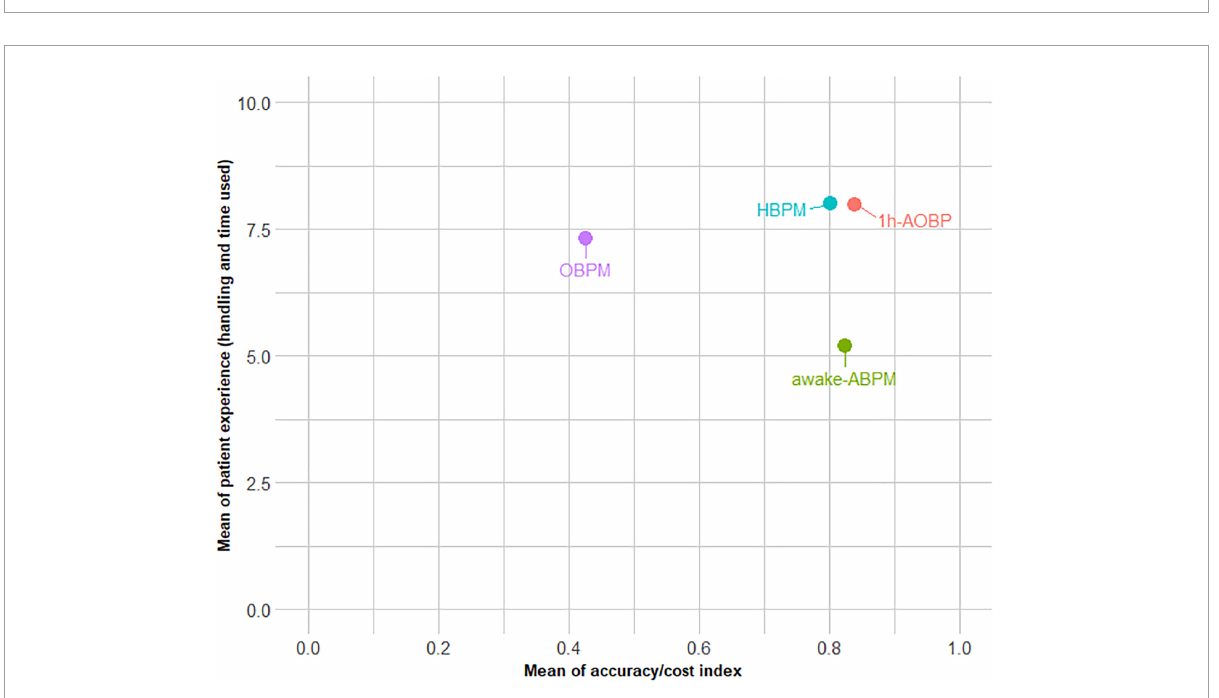
FIGURE3 Relationship between the cost-accuracy ratio and the patient experience. HBPM, Home blood pressure monitoring. 1 h-AOBP, 1 h- automated office blood pressure measurement; OBPM, Office Blood Pressure measurement; Awake-ABPM, Awake ambulatory blood pressure